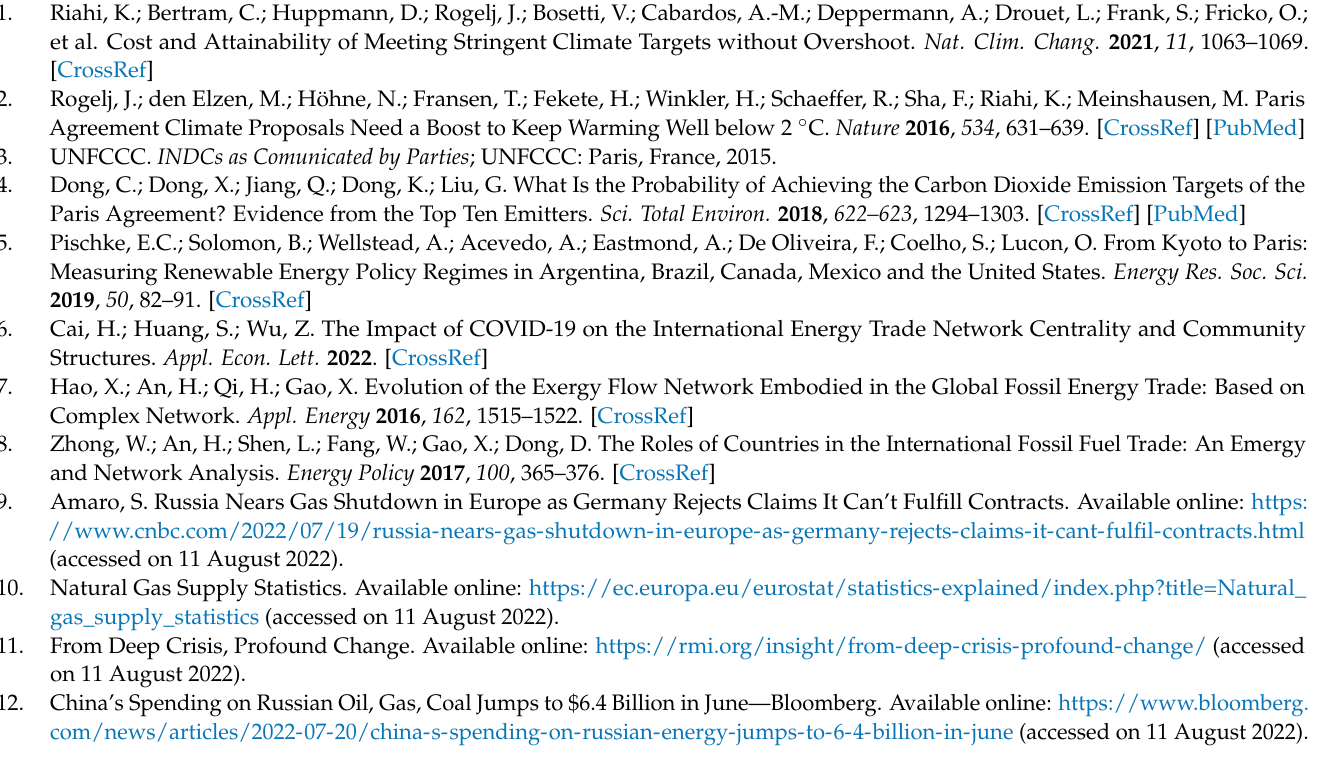
GLOBIOM; Table S5. Results of gravity model-based regression; Table S6. Fuel input required by type of shipping; Table S7. Capital costs assumptions by type of shipping and fuel; Table S8. Distance and payload assumptions by type of shipping and fuel; Table S9. Author-calculated costs converted into per GWa units; Table S10. Correspondence between Harmonized System (HS) 6-digit codes with energy commodities represented in the MESSAGE global energy model; Table S11. Network metrics for the global fuel trade network in 2050. Figure S1. (a) Validating converted trade data (BACI) with energy data (IEA) for China. (b) Validating converted trade data (BACI) with energy data (IEA) for Germany. (c) Validating converted trade data (BACI) with energy data (IEA) for Japan. (d) Validating converted trade data (BACI) with energy data (IEA) for Brazil; Figure S2. Map of nodes used in shortest path calculation; Figure S3. Distribution of estimated variable costs based on regression analysis; Figure S4. Results of a gravity model-based regression of trade cost ($/GWa) on